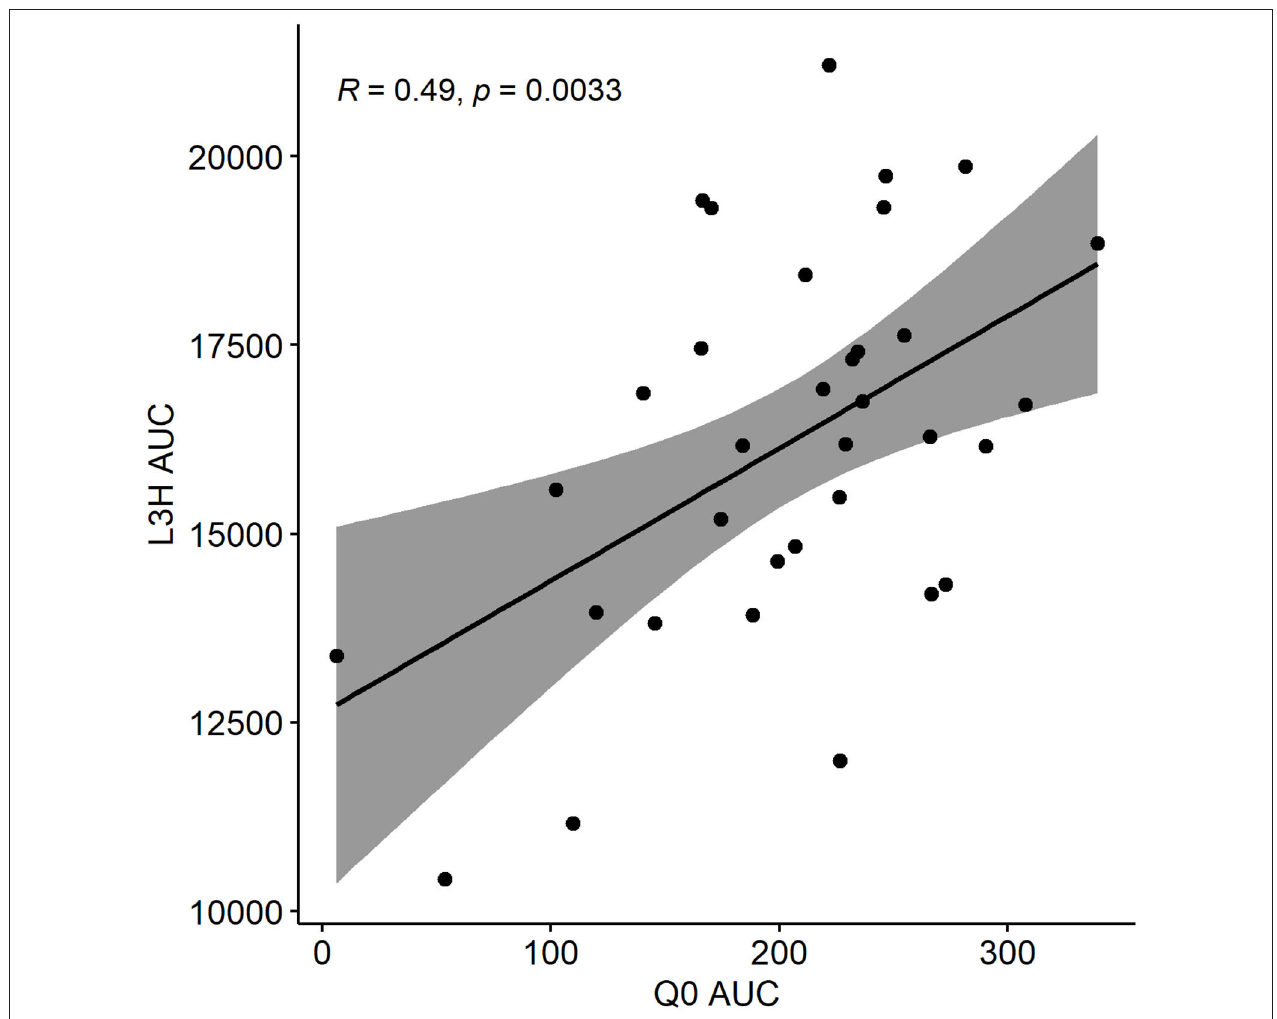
FIGURE 6 | AUC L3 h area under the curve